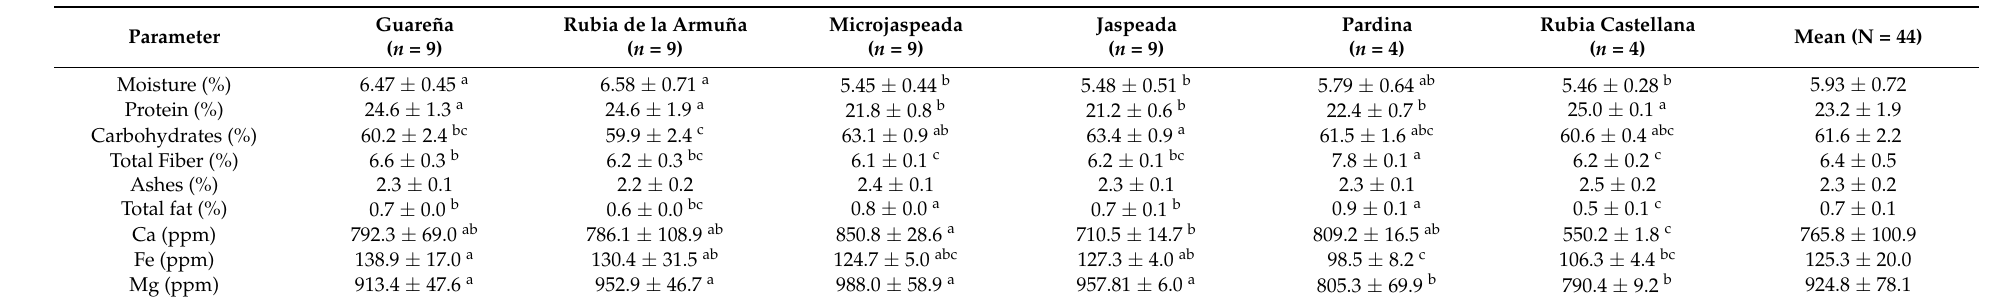
Table 5. Nutritional characteristics of the different lentil varieties (mean ± SD).